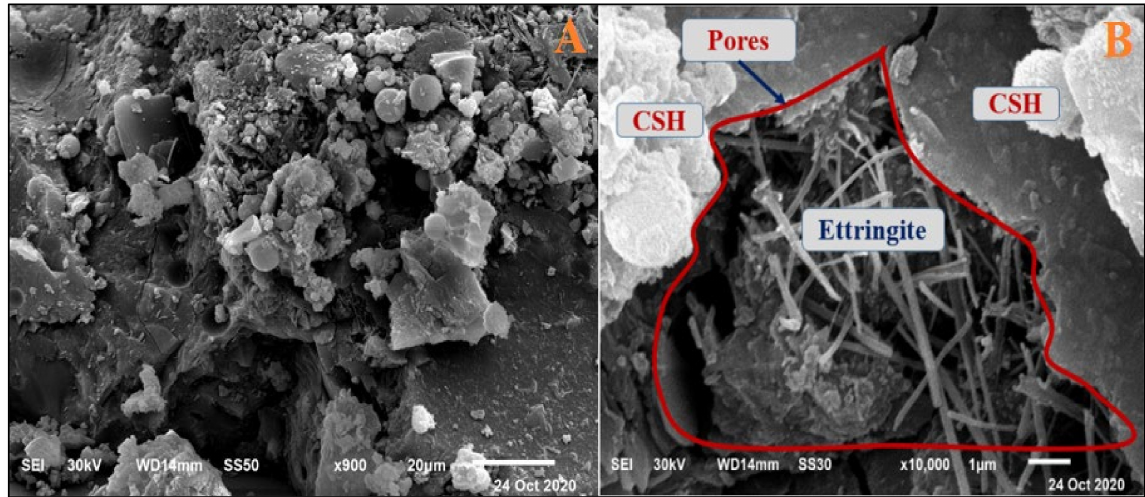
Figure 29. SEM of mix Z1 under sulfate exposure at 180 days: ( A ) at scale of 20 µ m, ( B ) at a scale of 1 µ m.